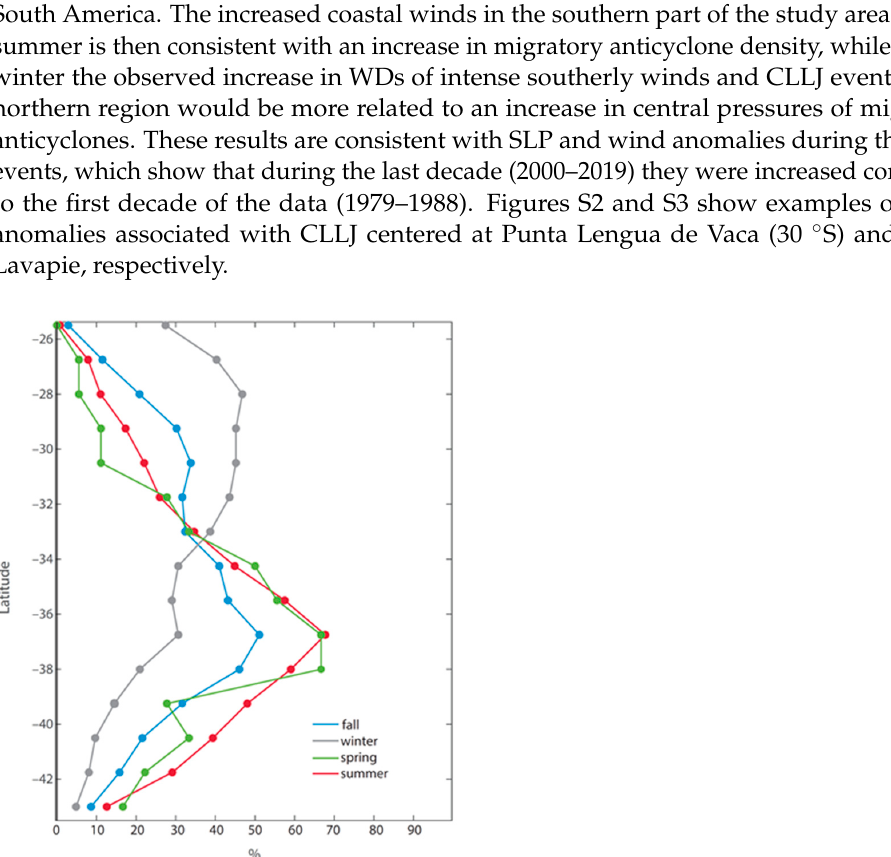
Figure 10. Probability that a V a greater than 10 ms − 1 occurs together with a migratory anticyclone inside the box defined in Figure 1.